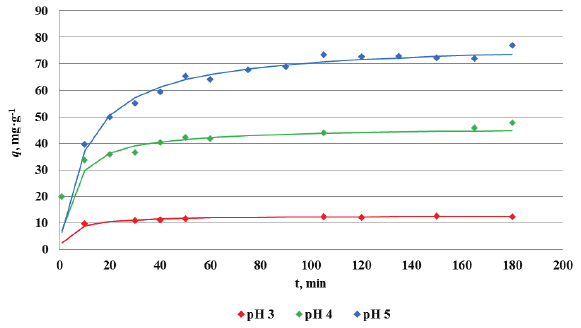
Figure 3: The kinetics of biosorption of Cr(III) ions at different pH